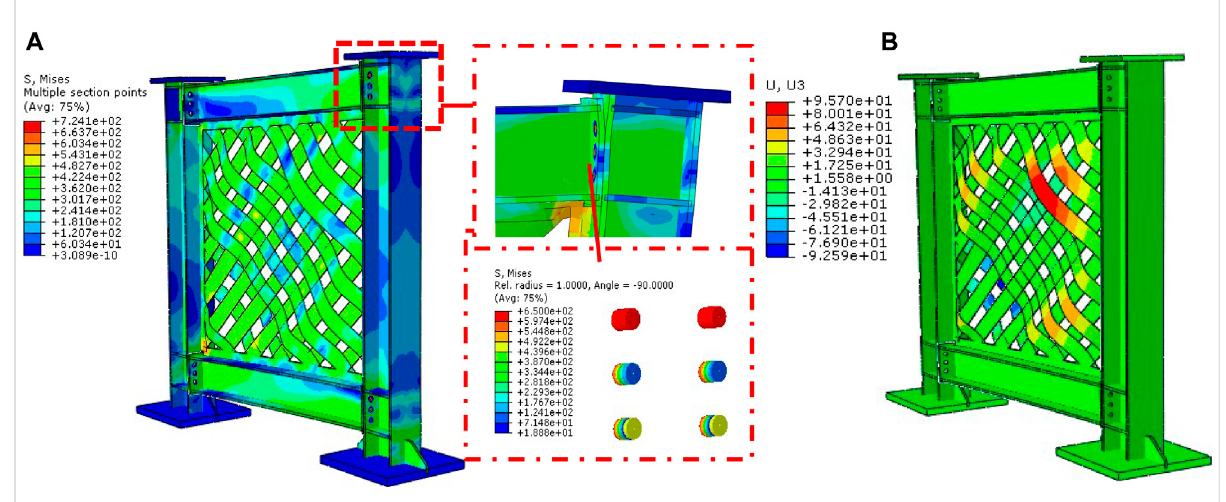
FIGURE 22 Von-Mises stress and post-buckling behavior of the parametric model, SW-3: (A) Von-Mises stress, and (B)